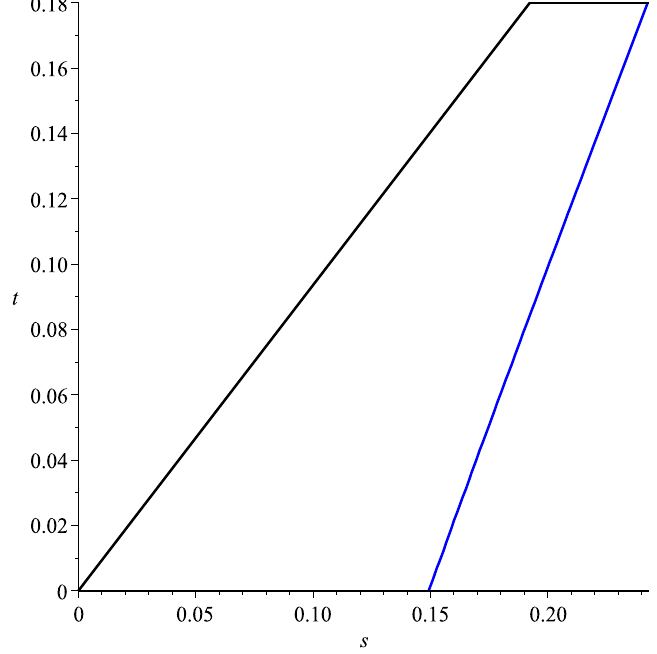
Figure 4. Allocation region, Path I in Blue and Path II in